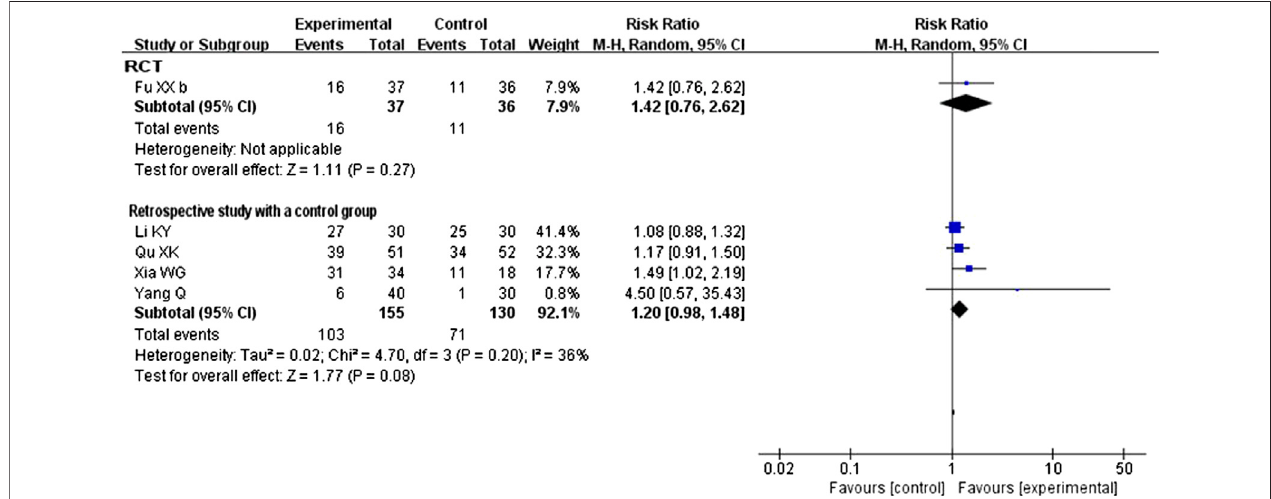
FIGURE 4 | Forest plot of cure rate: CHM plus conventional western therapy vs. conventional western therapy.